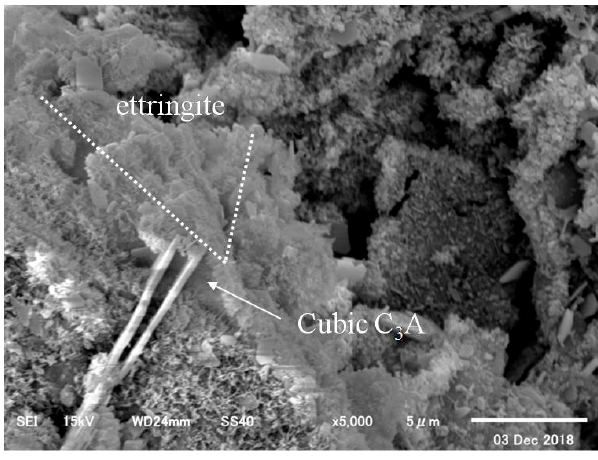
Figure 11. CN0 (×5000)–1. Figure 11. CN0 ( ×